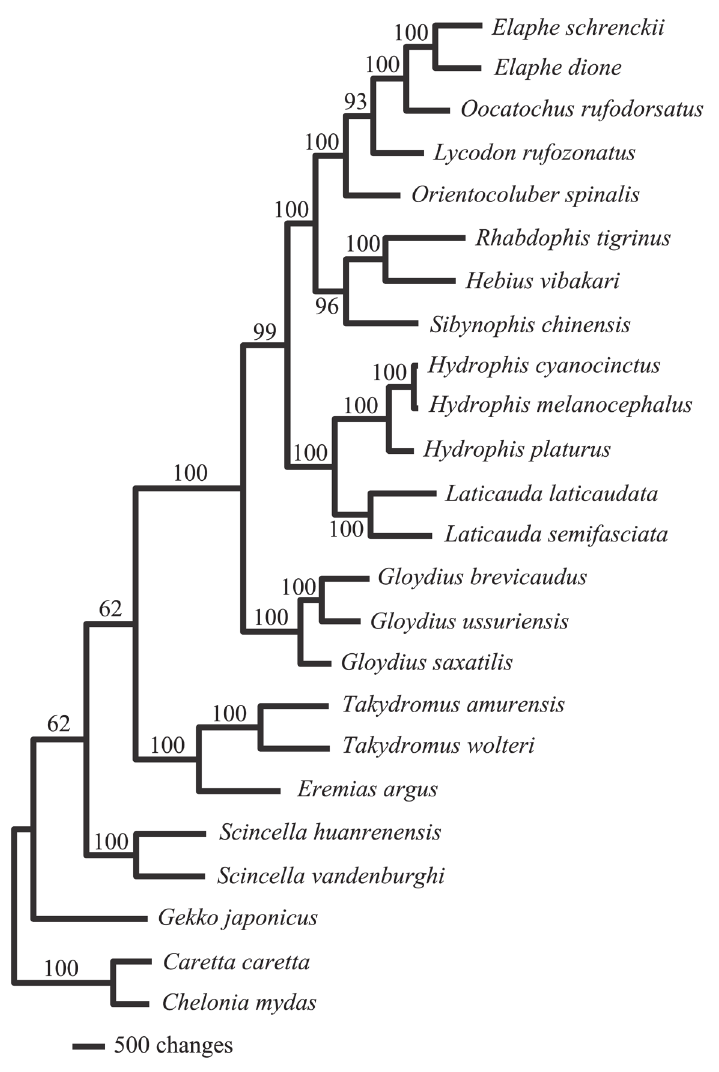
Figure 3. The constructed Bayesian Inference (BI) tree for all 22 squamate species listed in South Korea, based on 13 mitochondrial protein-coding genes. Two cheloniid species ( Caretta caretta and Chelonia mydas ) were used as outgroups. Bayesian posterior probabilities are denoted on each tree